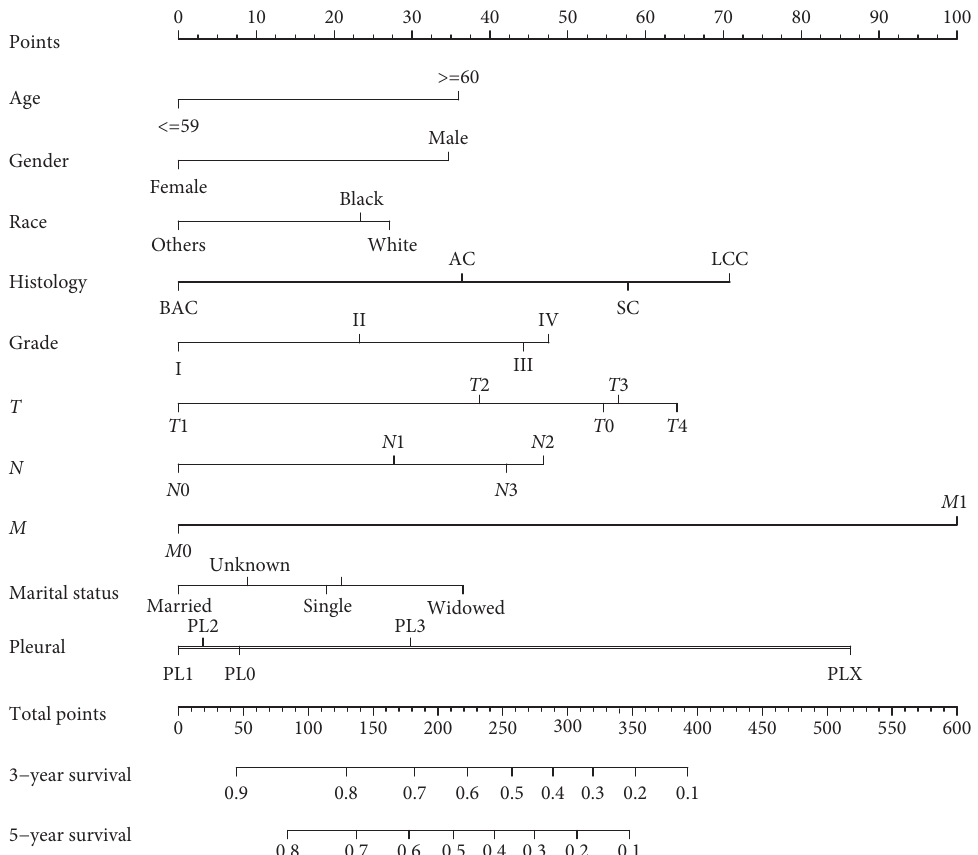
Figure 2: Nomogram for survival predicted probability. Each variable was individually evaluated for every patient and given a score subsequently. The higher scores obtained by summing the points of each variable from different patients indicate the poorer survival probability. Abbreviations: BAC, bronchioalveolar carcinoma; AC, adenocarcinoma; LCC, large-cell carcinoma; and SC, squamous cell